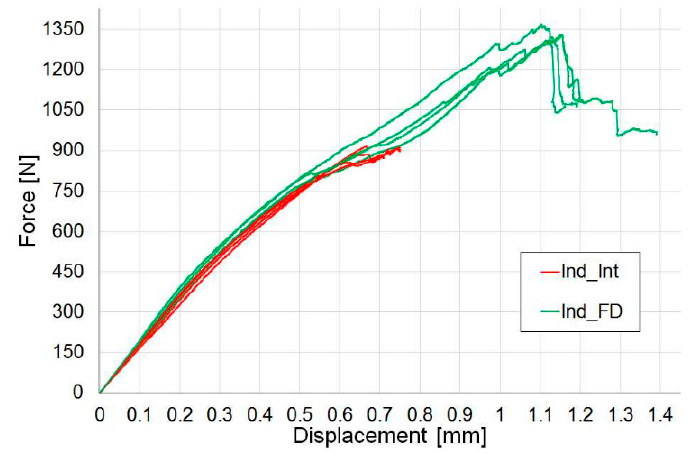
Figure 2. Indentation tests: load-displacement curves of Indented Fully Damaged (Ind_FD) and Indented Interrupted (Ind_Int) specimens.